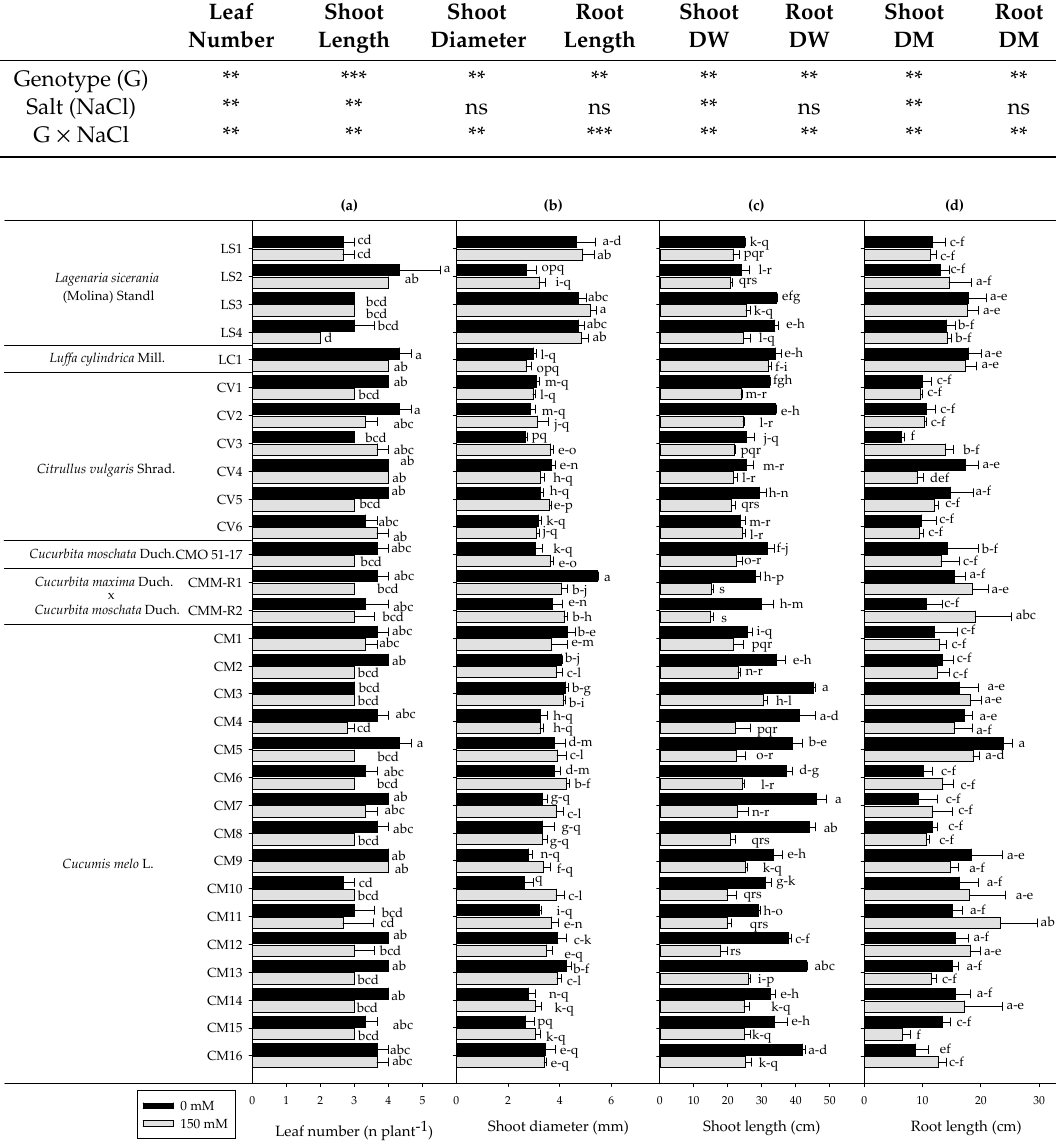
Table 2. Leaf number ( n plant − 1 ), shoot and root length (cm), shoot diameter (mm), shoot and root dry weight (DW, g plant − 1 ), and dry matter content (DM, %) in seedlings of sixteen Cucumis melo L., six Citrullus vulgaris Schrad., two C. maxima × C. moschata , four Lagenaria siceraria (Molina) Standl. different genotypes, and Cucurbita moschata Duch. cv 51–17 and Luffa cylindrica Mill. grown at 0 or 150 mM of NaCl. (1 week after the beginning of the treatment). Non significance or significance differences at p ≤ 0.05, 0.01, or 0.001 are indicated as: ns, ** and *** respectively.